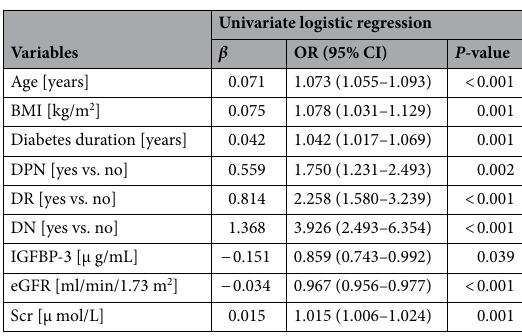
Table 2. Predictors identified by univariate logistic regression